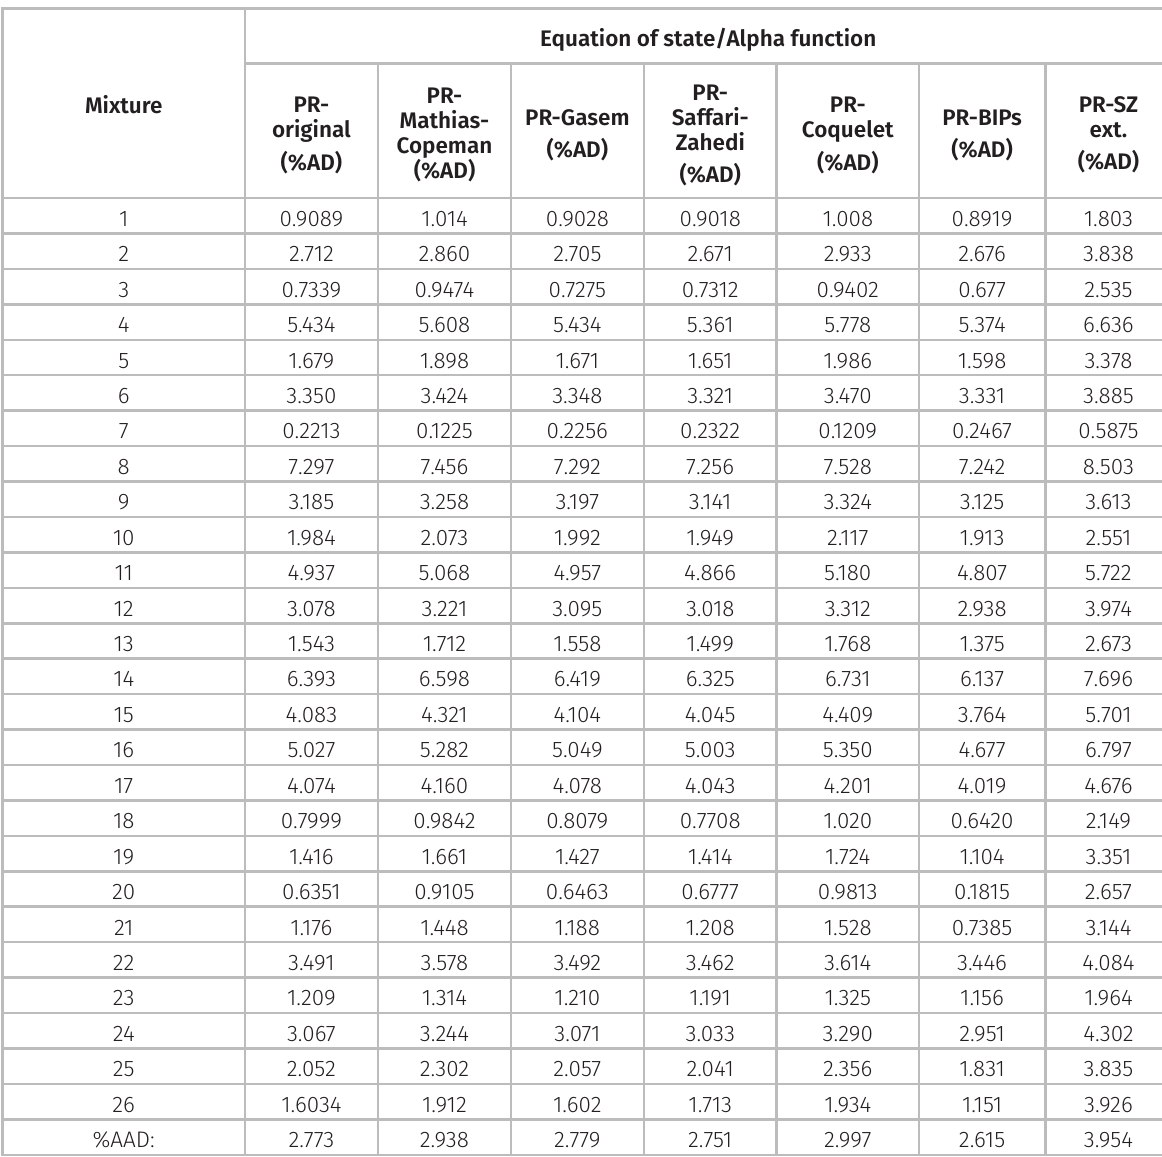
Table IX. Deviations of experimental and calculated enthalpy variation for gas-gas transitions.